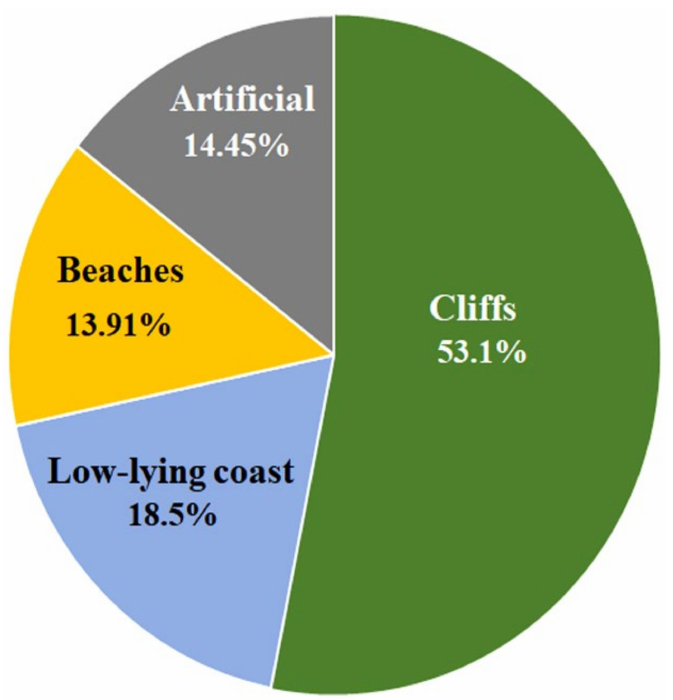
Figure 2. Coastal configuration of study area at regional scale. Date taken from